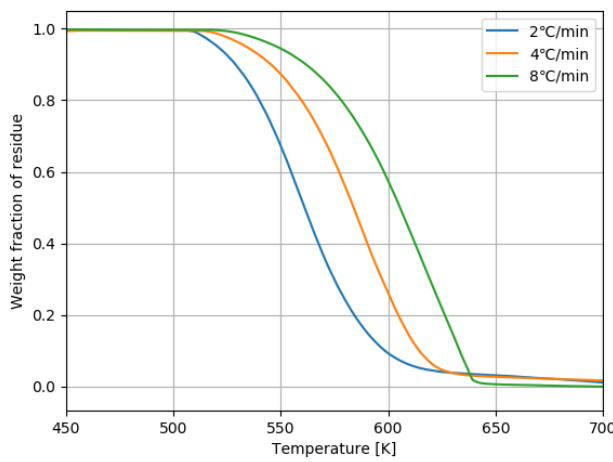
Figure 7. TGA curves with different constant heating rates for